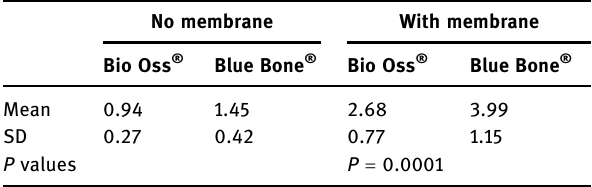
Table 5: Statistical analysis of osteocytes numbers in new